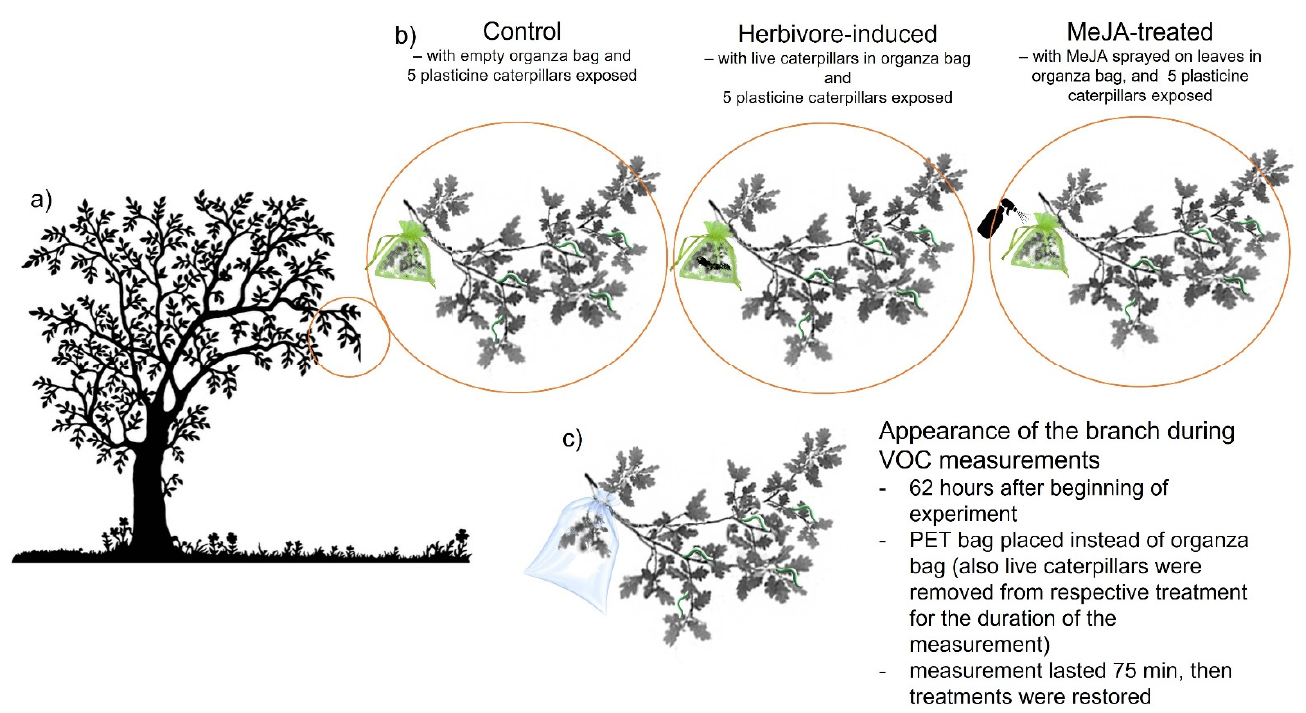
Figure 1. Experiment design showing the approximate location of an experimental branch at each of the focal trees ( a ), three respective treatments as they looked like in the 14 days long predation experiment—Control, herbivore-induced, MeJA-treated ( b ), and appearance of the branches during the measurement of volatile compounds ( c ). The measurement started 62 h after the beginning of the experiment, upon removal of the organza bag and real caterpillars from herbivore-induced treatment. Volatiles were then collected for 75 min. After that, the organza bag and live caterpillars were returned to their respective treatments. For the MeJA application ( b ), the organza bag was always removed, MeJA sprayed on the leaves inside, and the bag returned to the